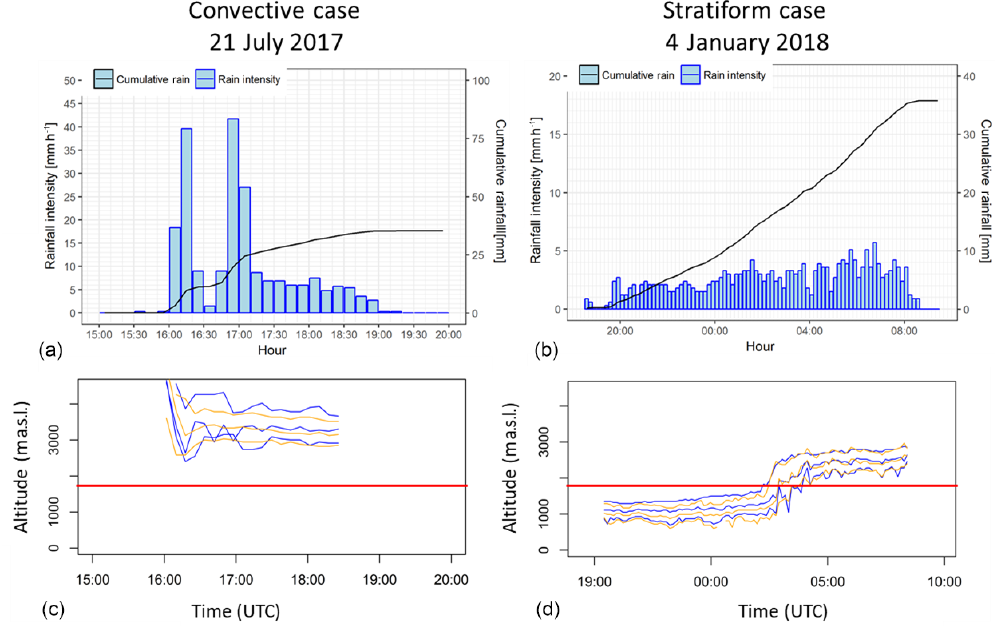
Figure 2. Description of two rain events considered in the present study: (a, c) convective case of 21 July 2017 and (b, d) stratiform case of 4 January 2018. (a, b) Rain rate and cumulative rainfall time series observed at the IGE site and (c, d) results of the ML detection algorithm based on XPORT 25 ◦ PPI data. The horizontal red line indicates the altitude of the MOUC radar (see text for details).